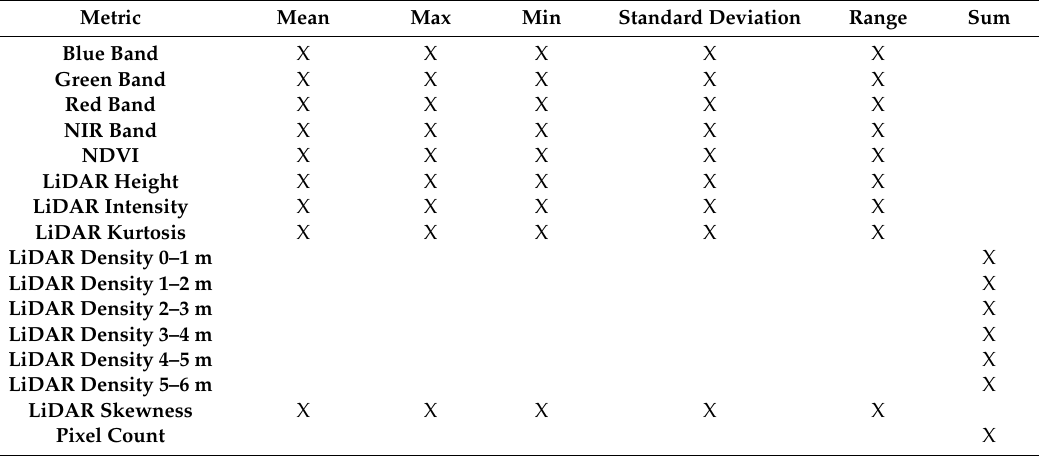
Table 1. Metrics used to perform 2016 classification. We computed a variety of metrics from the orthoimagery and LiDAR data. Using zonal statistics, we derived various statistical measures for each vegetation segment in the study